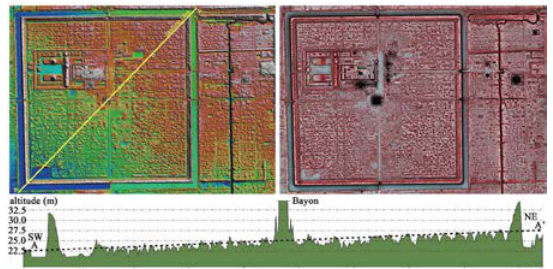
Figure 2. Comparison of color shaded relief map (left) and RRIM (right) for the Angkor Thom and east area, and section through northeast to southwest of Angkor Thom (bottom).